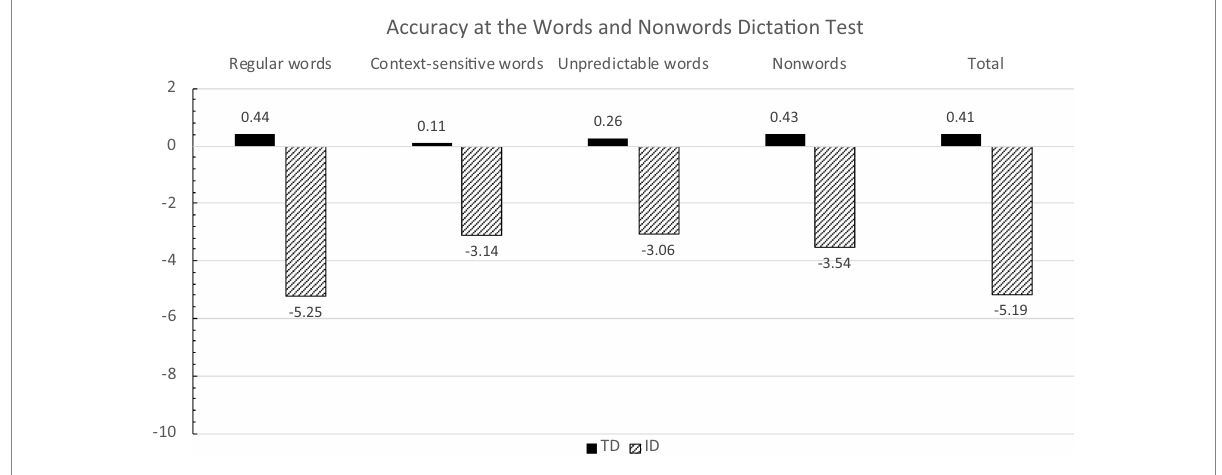
FIGURE 2 Mean accuracy z scores in the total and in the four sections of Words and Nonwords Dictation Test by control and ID children.